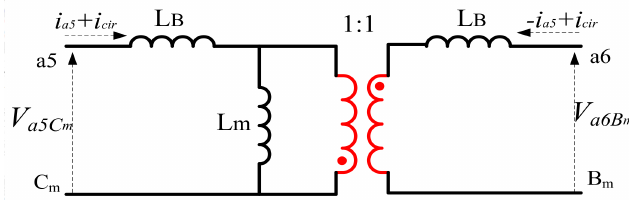
Figure 3. Equivalent circuit for the two-winding magnetic